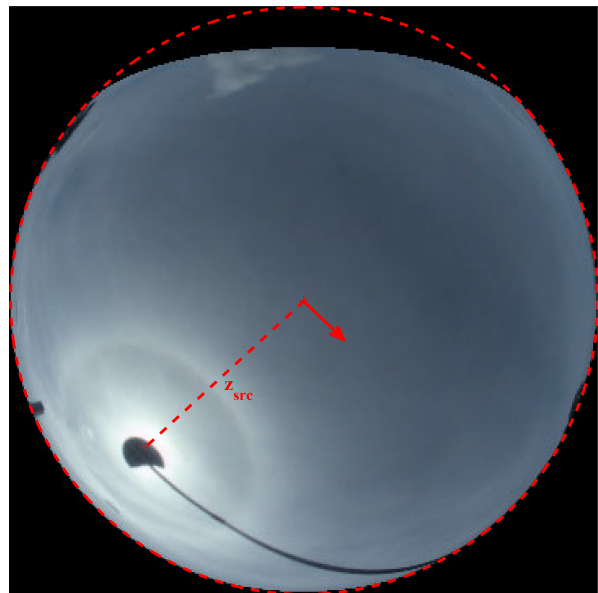
Figure 4. Projection of the original image from Fig. 3 onto a sphere (upper hemisphere). The unit vector u determines the direc- tion around which the rotation that leads to the sun-centred image, Fig. 5, takes place; z src is the light source zenith